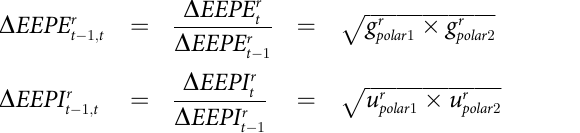
p ffiffiffiffiffiffiffiffiffiffiffiffiffiffiffiffiffiffiffiffiffiffiffiffiffi (cid:2) g r g r polar 1 polar 2 p ffiffiffiffiffiffiffiffiffiffiffiffiffiffiffiffiffiffiffiffiffiffiffiffiffiffiffi (cid:2) u r u r polar 1 polar 2